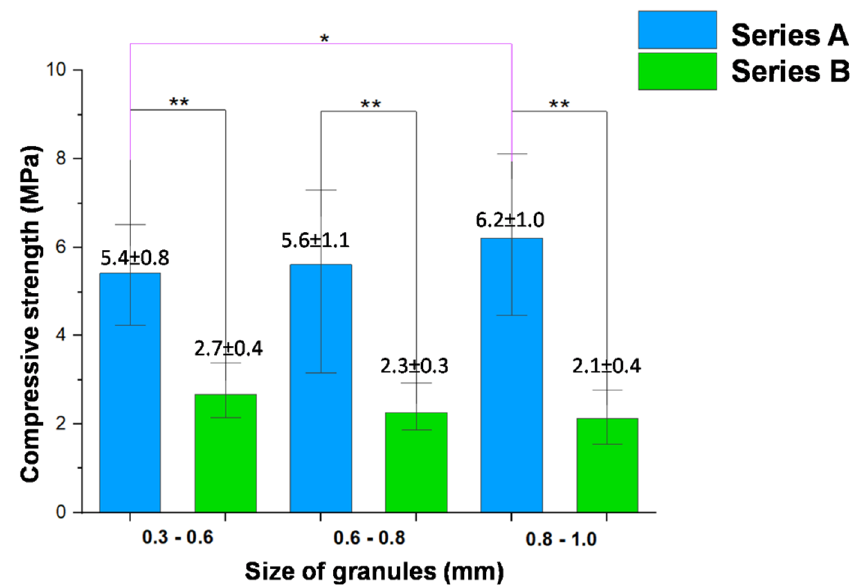
Figure 6. Compressive strength of biomicroconcretes after 7 days of setting and hardening in the air (statistically significant difference: * p < 0.05, ** p < 0.0001).